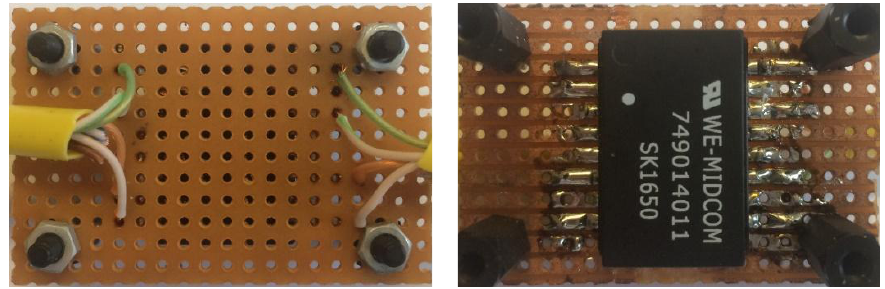
Figure 21. Front ( right ) and back view ( left ) of completed Ethernet isolator board.